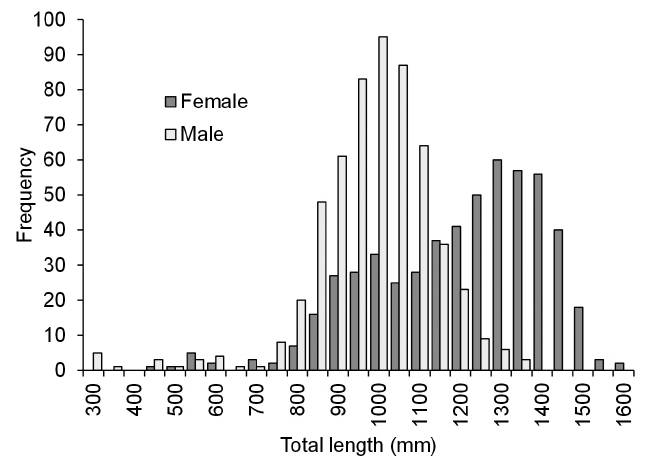
FIGURE 3 | Total length (TL) frequency distribution of Pseudoplatystoma corruscans specimens discriminated by